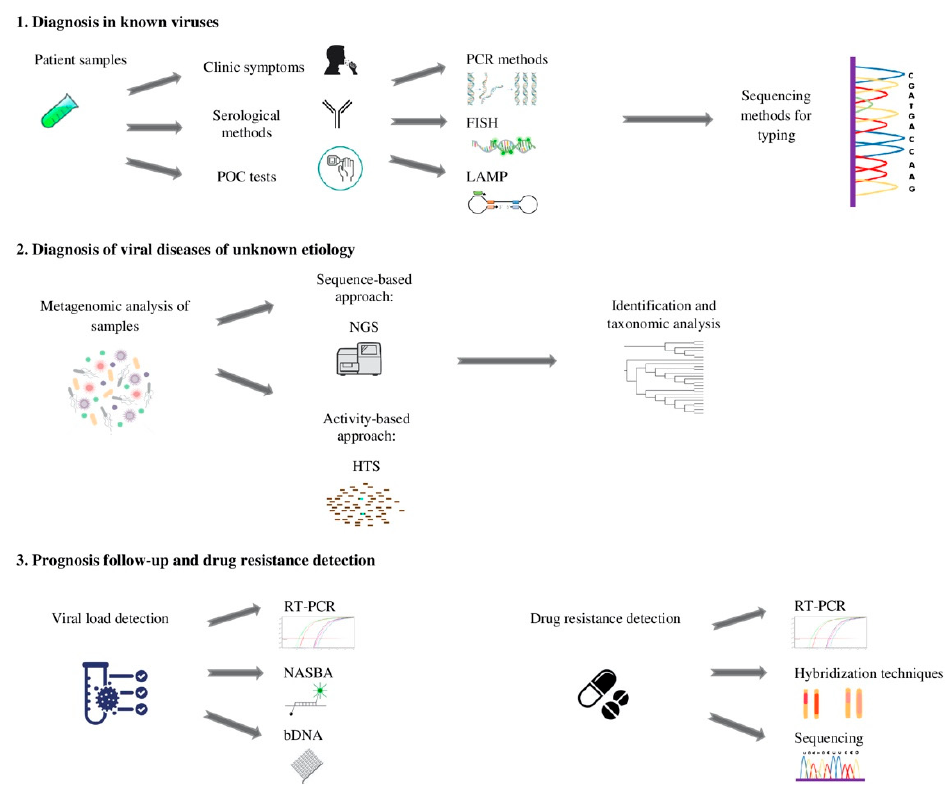
Figure 1. Flow chart used in the management of viral diseases: 1. An approach for the identification of known viruses; 2. The evaluation of virus populations for the detection of emerging viruses; 3. Appropriate techniques for viral disease prognosis monitoring and drug